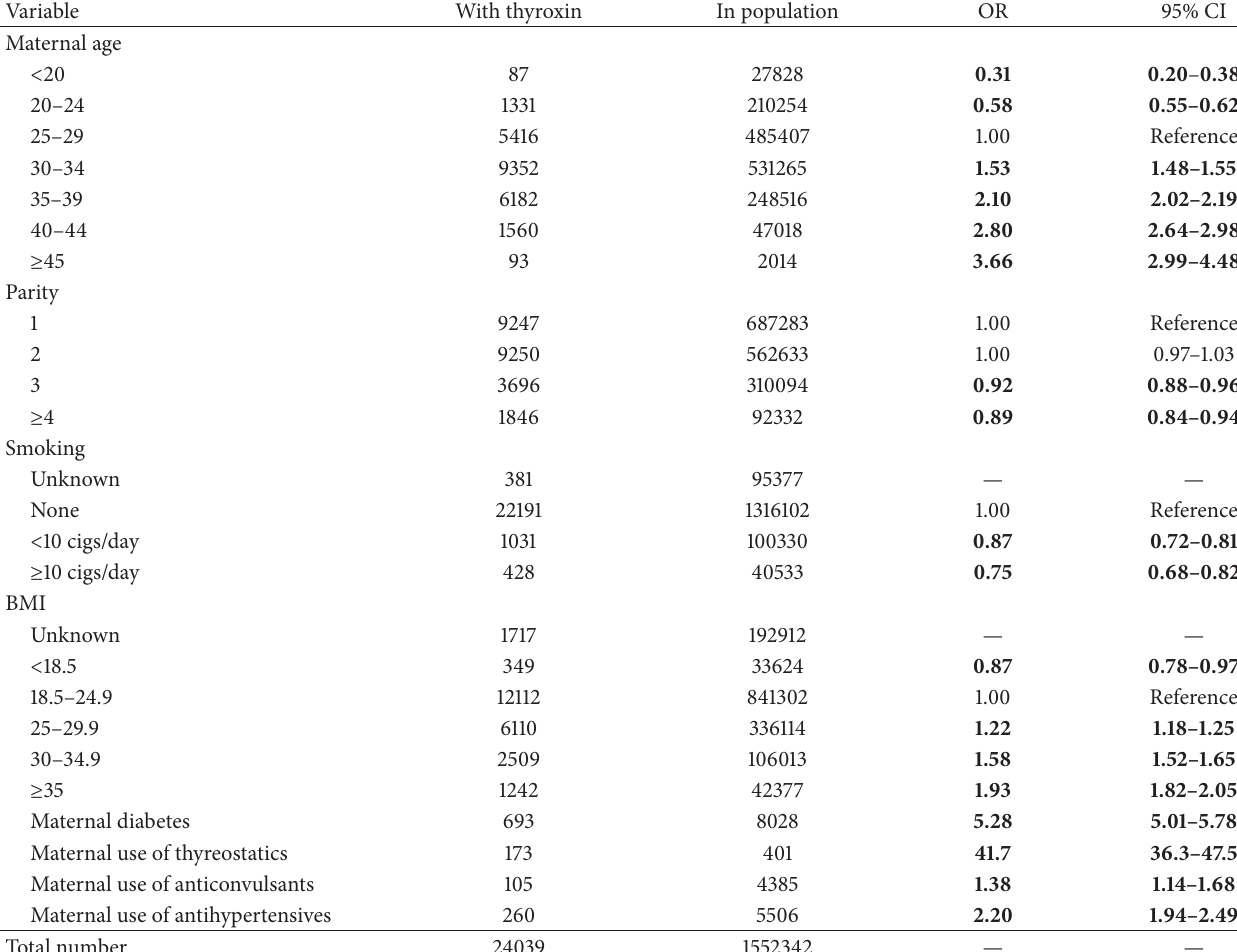
Table 1: Characteristics of women who reported the use of thyroxin in early